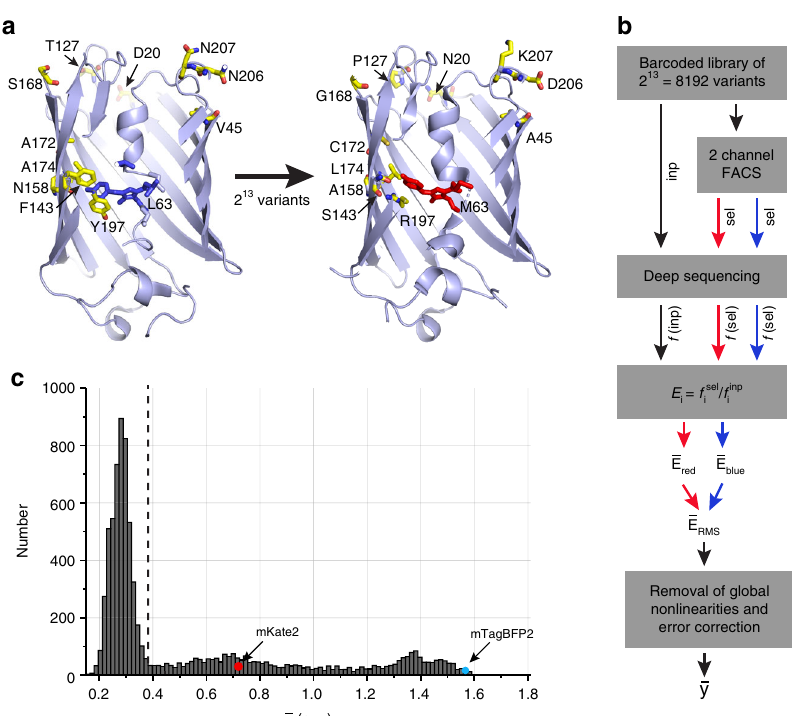
Fig. 1 Combinatorial mutagenesis and data collection. a mTagBFP2 (left) and mKate2 (right) are blue and red variants, respectively, of the Entacmaea quadricolor fl uorescent protein eqFP611 18 that differ by 13 amino acid substitutions (12 shown; the 13th is at position 231, at the C-terminal end of the molecule and is not shown in the crystal structure). This de fi nes a total sequence space linking the two of 2 13 = 8192 variants. b A schematic of the experimental protocol in which every variant is assigned a quantitative phenotype ( (cid:1) y ) — brightness, a combination of fl uorescence in both red and blue channels (see “ Methods ” for details). The phenotype is computed such that the independent action of mutations outside of the selection threshold corresponds to additivity. c The distribution of phenotypes for all 8192 variants; the dashed line corresponds to the detection threshold for fl